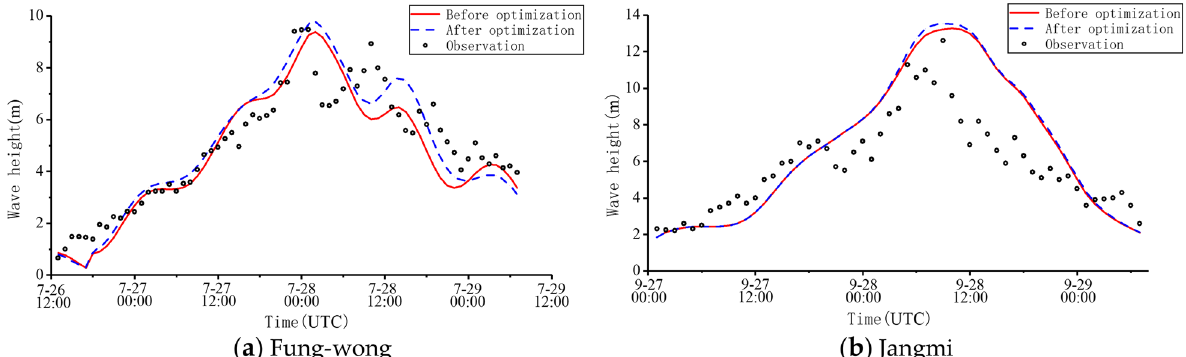
Fig. 7 Comparison between calculated and measured values of significant wave height before and after the